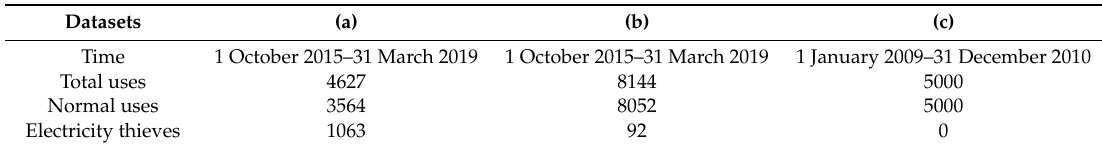
Table 1. Datasets’